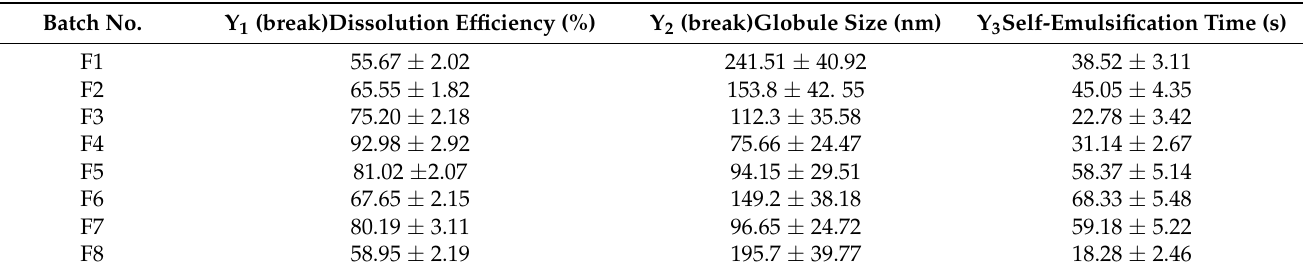
Table 4. Responses of designed batches for dependent variables (dissolution efficiency %; globule size; and self-emulsification time).